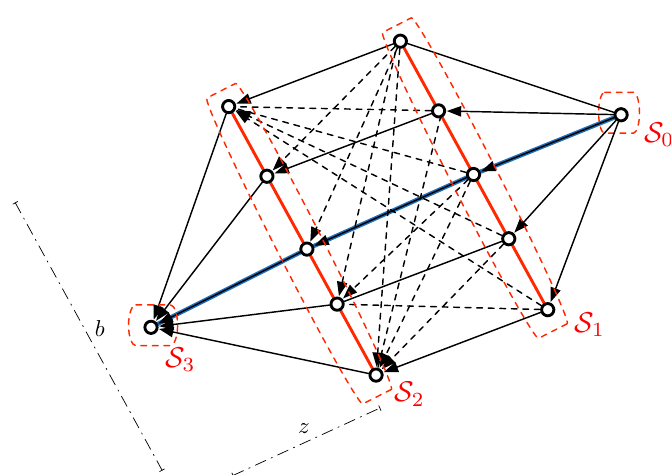
Figure 2. Example of navigation graph built around the nominal route in blue. This navigation graph is defined by m = 3 stages with q = 5 nodes per stage. The stages departure and destination nodes,